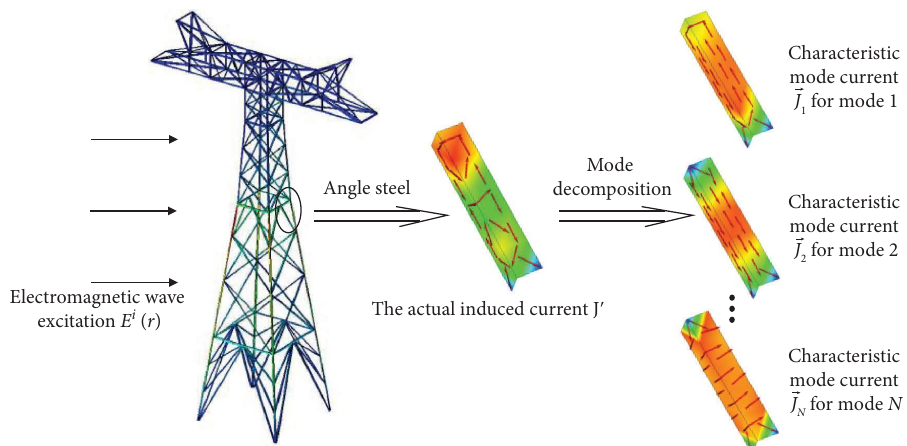
Figure 2: Schematic diagram for the mode decomposition of the induced current on PTL.